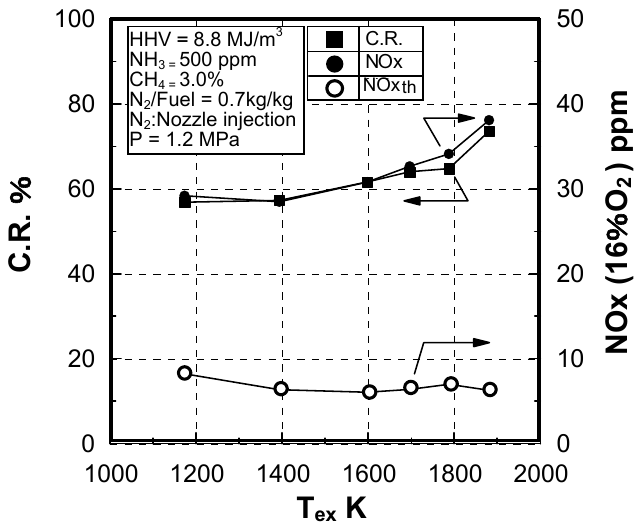
Figure 78. Effect of combustor exhaust gas temperature on NOx emission